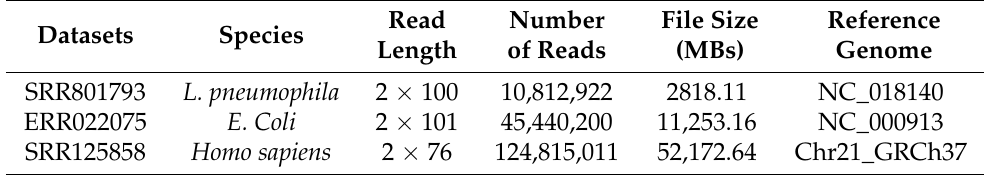
Table 3. NGS datasets used for experiments.